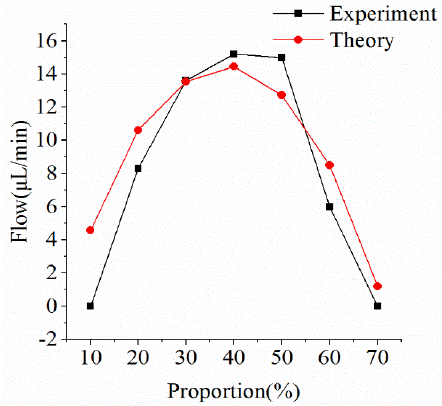
Figure 8. Comparison of theoretical flow and experimental flow at a heating frequency of 50 Hz.